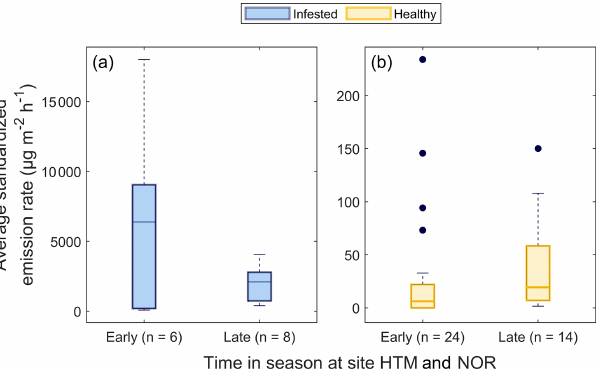
Figure 6. Boxplots of the temperature standardized emission rates of (a) the infested Norway spruce trees (blue) and (b) the healthy Norway spruce trees (yellow) during the early and late season. The healthy trees were measured in Hyltemossa, and infested trees were measured both in Hyltemossa and Norunda. To consider the sea- sonal pattern of the spruce bark beetle, the infested trees were di- vided into early and late season, where the early season is domi- nated by entry holes and the late season by exit holes. The number of daily averages is indicated by n , and the black dots indicate outliers. The difference in emission rates for the infested and healthy trees was tested using a Kruskall–Wallis test (MATLAB R2021a, Math- Works, Inc., MA, USA). The emission rates from infested trees dur- ing both seasons were significantly higher compared to the healthy trees ( P < 0.001 for both), while there was no significant differ- ence between the early and late season for the healthy trees only ( P > 0.4) or the infested trees only ( P >